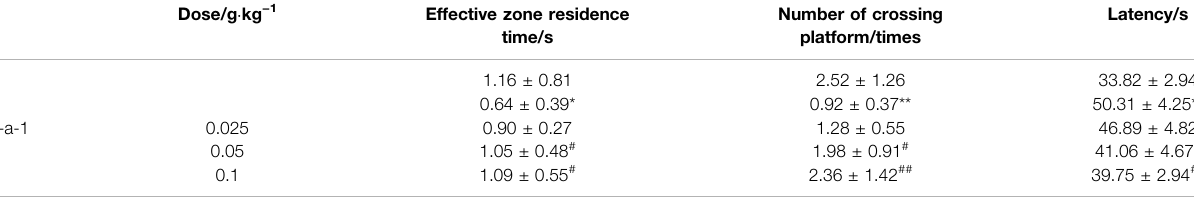
TABLE 1 | Effects of AMP-N-a-1 on the performance of mice with learning and memory disorders in the Morris water maze test ( n = 18, mean ± s). Group